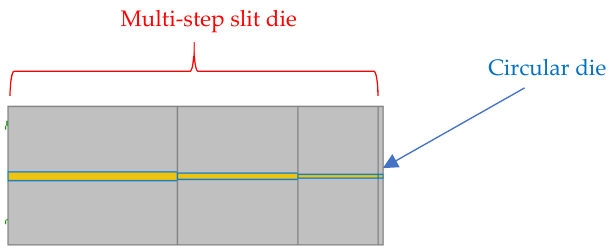
Figure A1. Die profile used in pea flour extrusion. It consists of a combination of a rheometric die and a cylindrical die. The schema is drawn with Ludovic ® software according to description given by Horvat et al. [26]. The rheometric die is a slit-die built up by a triple-step insertion module in a slit channel having a width of 30 mm. The geometry (length and height) of each step is given as follows: step 1—170 × 7 mm 2 ; step 2—120 × 5 mm 2 , and step 3—80 × 3 mm 2 . The cylindrical die is built up by a plate with a hollow/cylindrical channel having a diameter of 3 mm and three options of length (5, 10, and 15